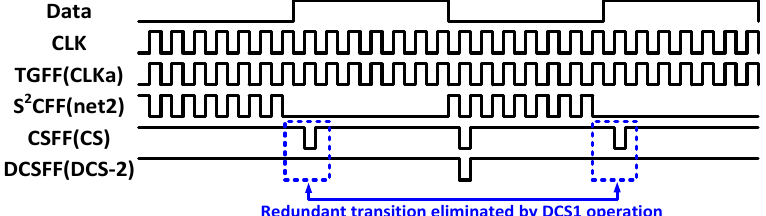
Figure 5. Timing Diagram of Redundant Transitions between the Proposed One and Others.